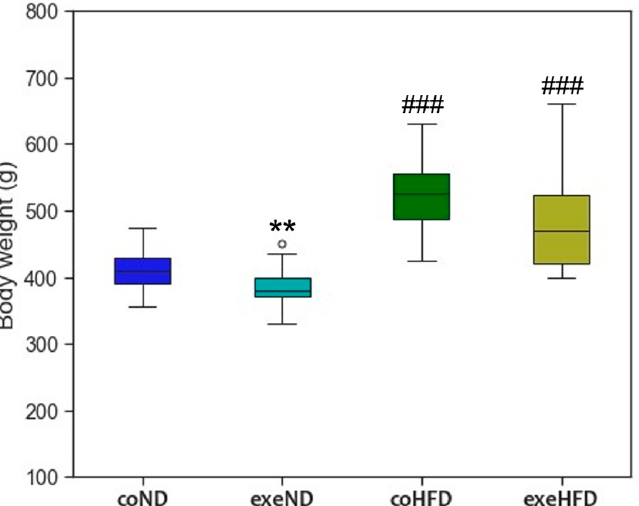
Figure 1. Box and Whisker plot of the body weight at the end of the 10 months study period. Outliers are shown as white circles above the box plots. The two-tailed Student’s t -test was used for group comparison of independent samples. ** p < 0.01 compared to appropriate sedentary control group; ### p < 0.001 compared to appropriate normal diet control group.